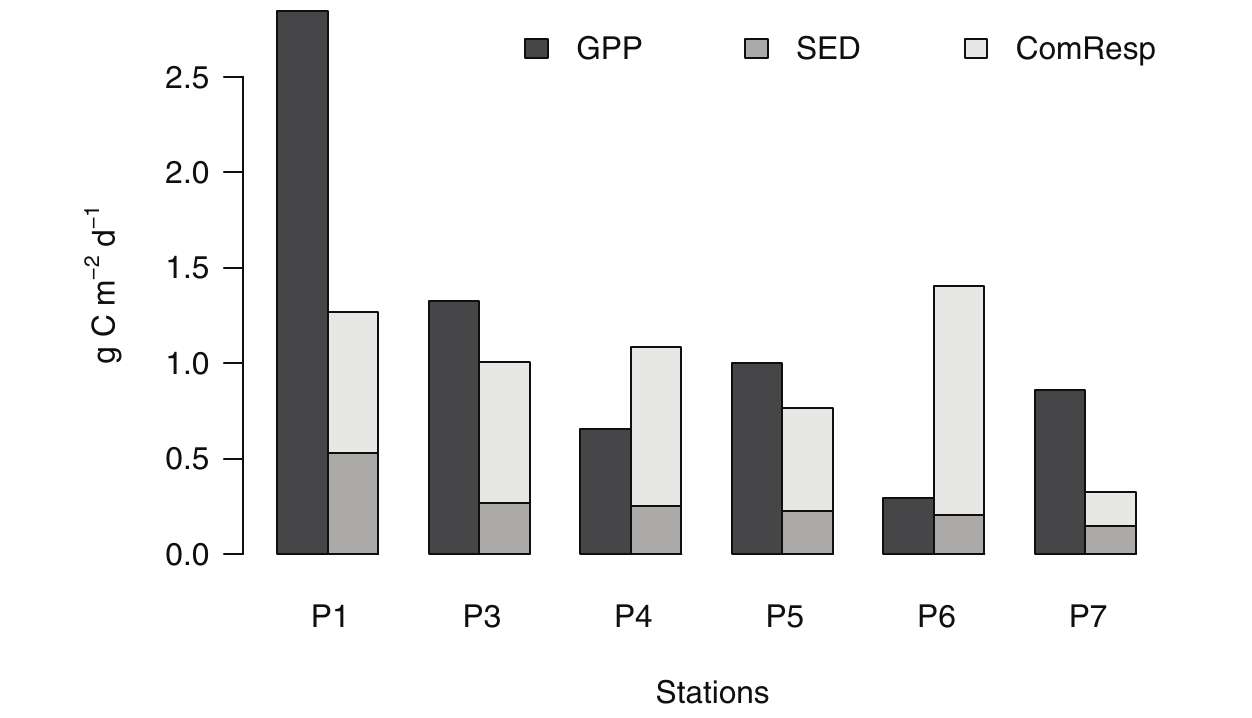
FIGURE 4 | External flows into the food web, gross primary production (GPP), and two loss rates: the vertical flux of particles (SED), and community respiration (ComResp). Whenever GPP exceeds the sum of SED and ComResp, the food web is increasing in mass, and vice versa.